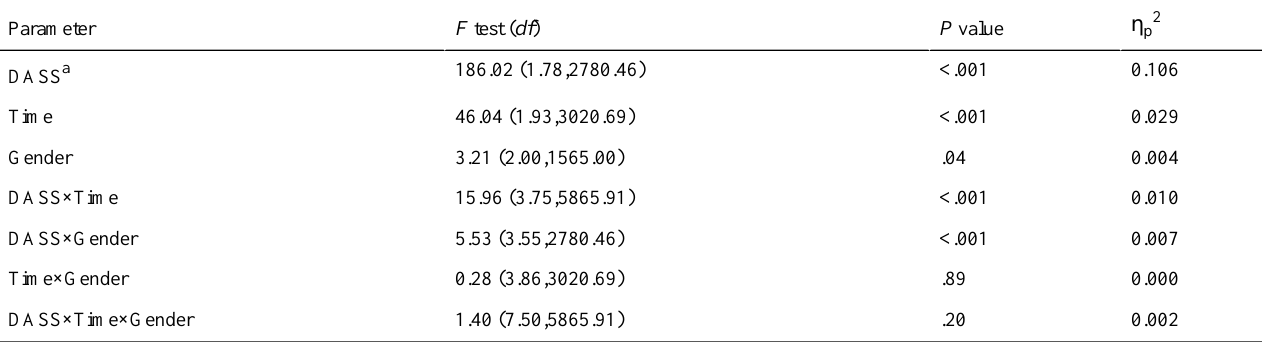
(Table 4). The 3-way interaction between age group, DASS-21, Table 3. Repeated measures effects of DASS across time, by